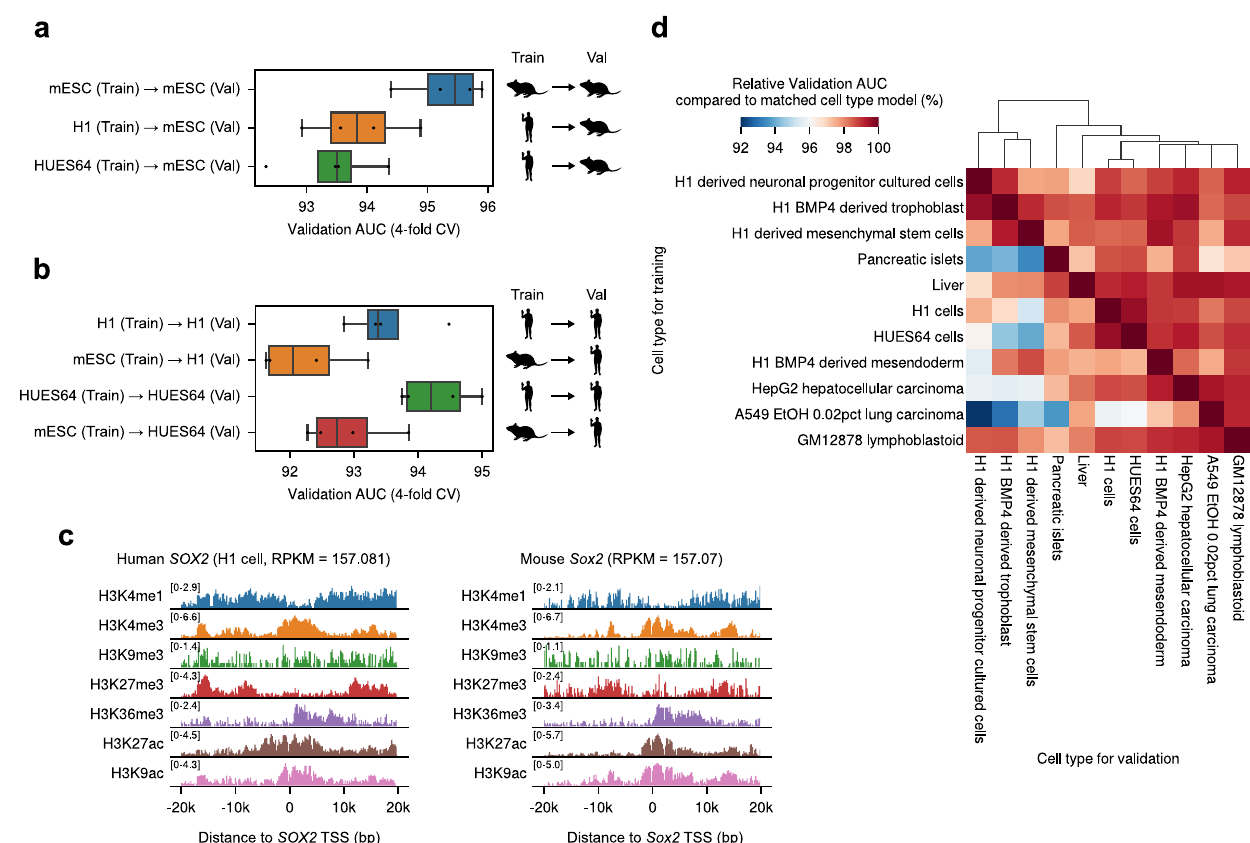
Fig. 8 | Cross-species and cross-cell type prediction performances of Chromo- former. a, b Cross-species prediction performances of Chromoformer-clf models. a Cross-validation ( n =4) performances of Chromoformer-clf models, trained with ES-Bruce4 mouse embryonic stem cells (mESC) or human embryonic stem cells (hESCs), are shown for the prediction of ( a ) mESC gene expression and ( b ) hESC gene expression. In the boxplot, the center line denotes the median, upper and